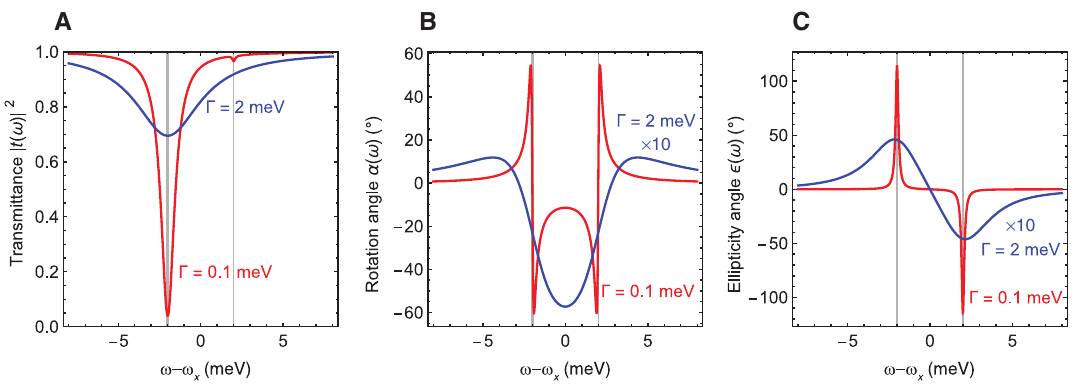
Figure 2: Optical properties of chiral bilayers ( N = 2). (A) Transmittance | t ( ω )| 2 , (B) polarization rotation angle α ( ω ), and (C) ellipticity angle ε ( ω ). Vertical lines indicate the frequencies of the symmetric (thick line) and antisymmetric (thin line) exciton modes in the bilayer. The dependences are calculated for the parameters Γ = 0.3 meV [46], J = 2 meV, qd = 0.01 (which corresponds to d ~ 1 nm at the exciton transition energy 2 eV), φ = 0.1, and the nonradiative 0 exciton decay rates Γ = 0.1 meV (red curves) and 2 meV (blue